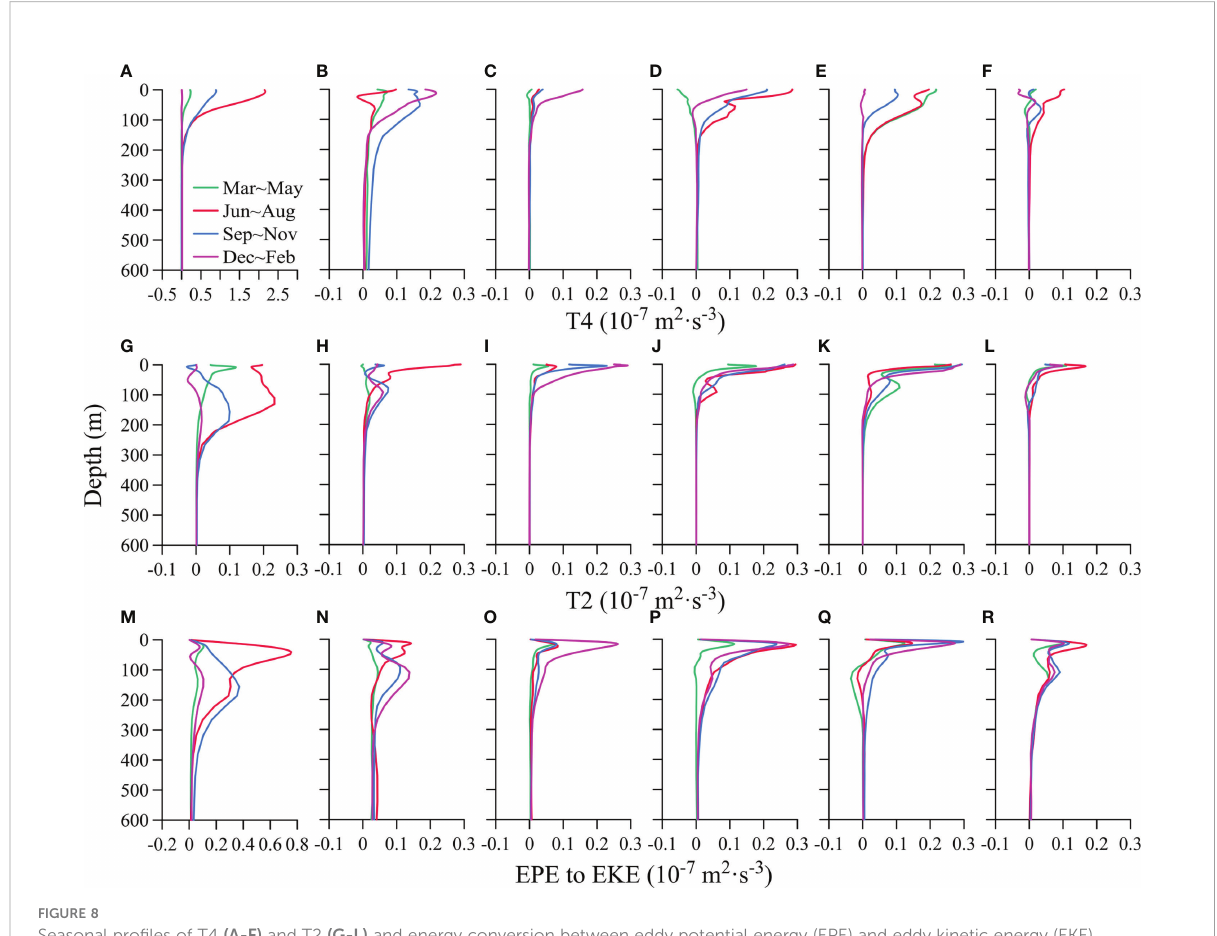
FIGURE 8 Seasonal pro fi les of T4 (A-F) and T2 (G-L) and energy conversion between eddy potential energy (EPE) and eddy kinetic energy (EKE) (M-R) averaged in the A1, A2, A3, B1, B2, and B3